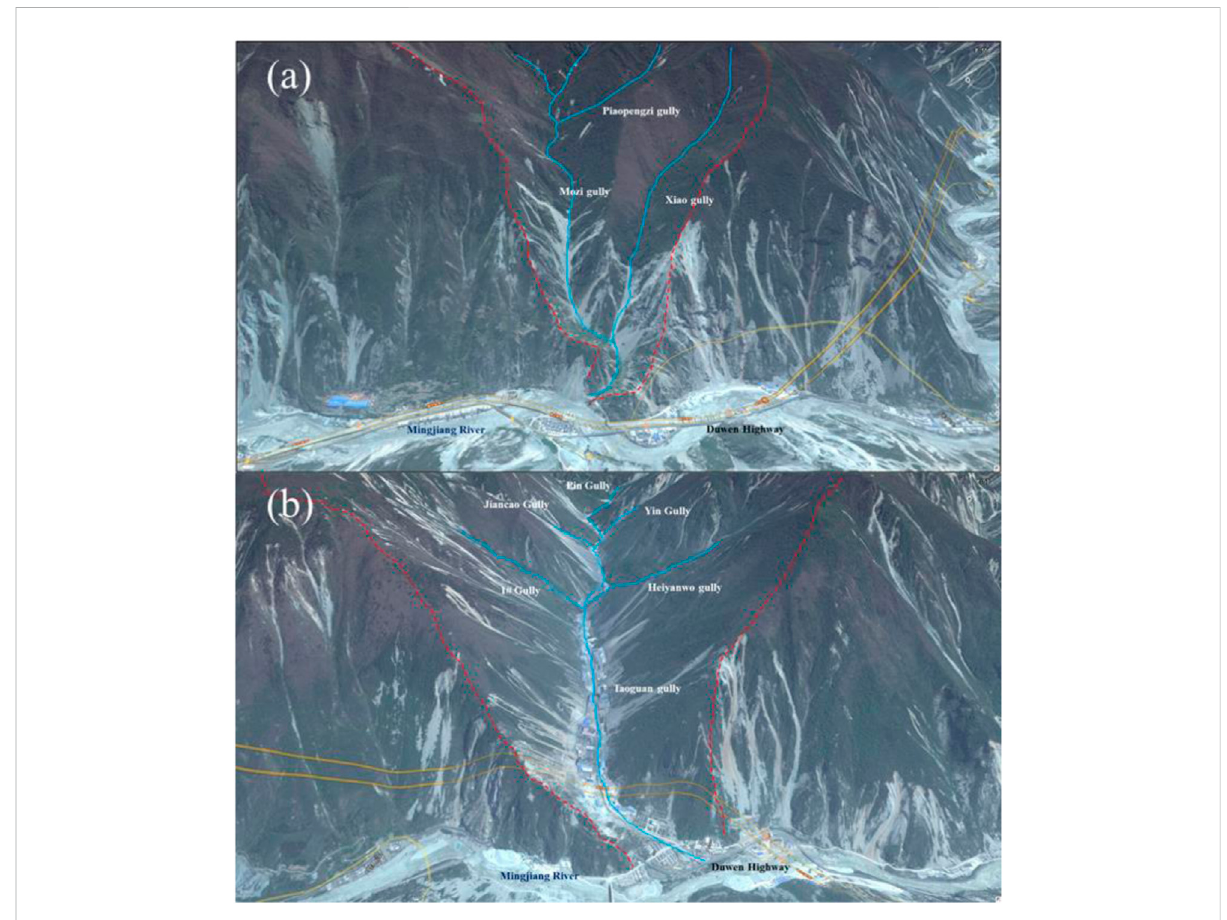
FIGURE 10 Thetypicalnarrow-steepandwide-gentledebris fl owgullies: (A) Thetypicalnarrow-steepdebrisgully:Mozigully(thewatershedarea:7.4 km 2 , theaverageverticalslope:424 ‰ ,with “ V ” shapedsection) (B) Thetypicalwide-gentledebrisgully:Taoguangully(thewatershedarea:50.86 km 2 ,the average vertical slope: 197 ‰ , with “ U ” shaped